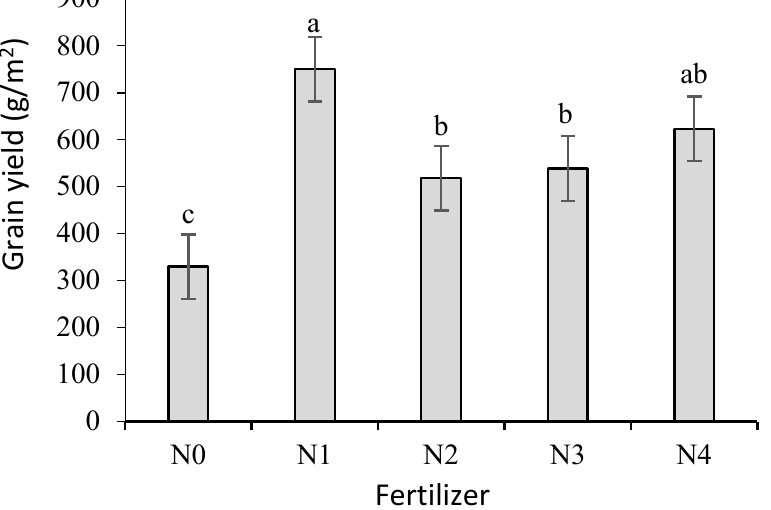
Figure 2. Changes in dill grain yield under chemical and bio-fertilizer treatments. Different letters